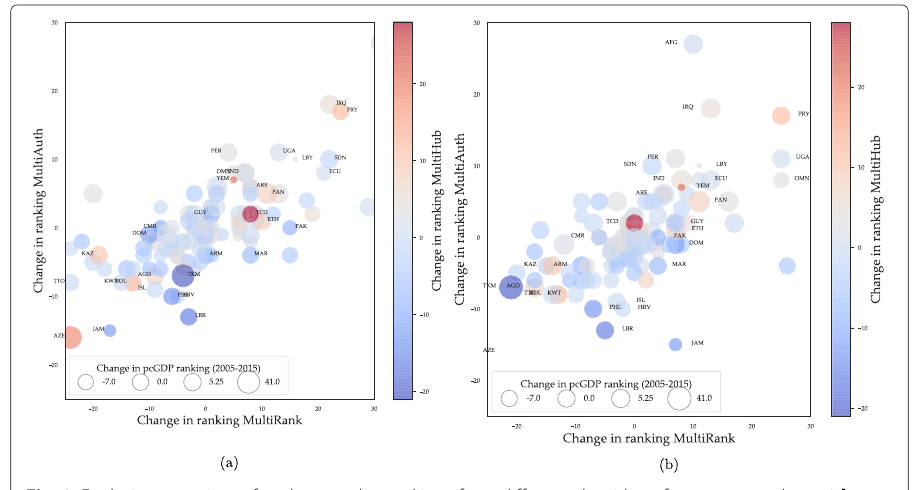
Fig. 8 Evolution over time of node centrality rankings from different algorithms for a = 1 a and a = 0 b . Labels are provided for the top and bottom 10 nodes in the evolution of the MD-HITS scores